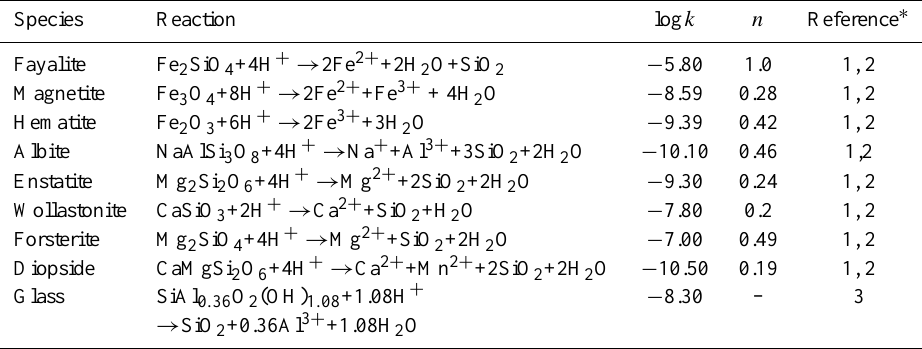
Table A3. Ash dissolution reactions and rate parameters.